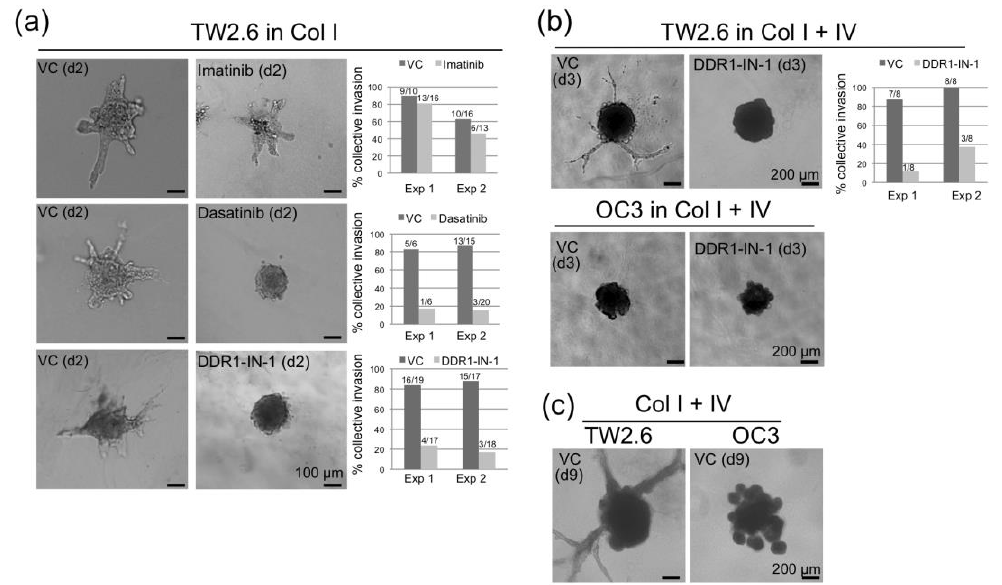
Figure 6. Kinase activity of DDR1 is involved in spheroid invasion. ( a ) Representative bright-field images of two-day TW2.6 cell spheroids embedded in collagen I gel matrix with vehicle control (VC) or DDR1 inhibitors (10 µ M imatinib, 0.1 µ M dasatinib, 10 µ M DDR1-IN-1). In each assay, a protrusion with > 100 µ m extension from its spheroid central body was counted as a branch; a spheroid with at least two branches was scored positive for collective invasion. The results of two independent experiments are summarized on the right. The fraction on each graph bar denotes positive (numerator) and total (denominator) numbers of spheroids examined. ( b ) Bright-field images of three-day TW2.6 and OC3 spheroids embedded in collagen I and IV gel matrix with VC or 10 µ M DDR1-IN-1. ( c ) Bright-field images of nine-day TW2.6 and OC3 spheroids embedded in collagen I and IV gel matrix with VC only.